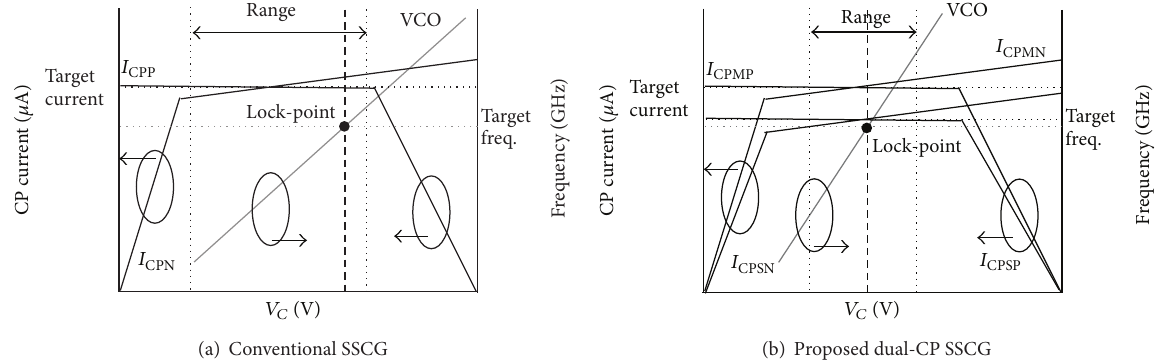
Figure 5: The explanation of CP current characteristics and VCO frequency current characteristics of the conventional SSCG (a) and the proposed dual-CP SSCG (b).